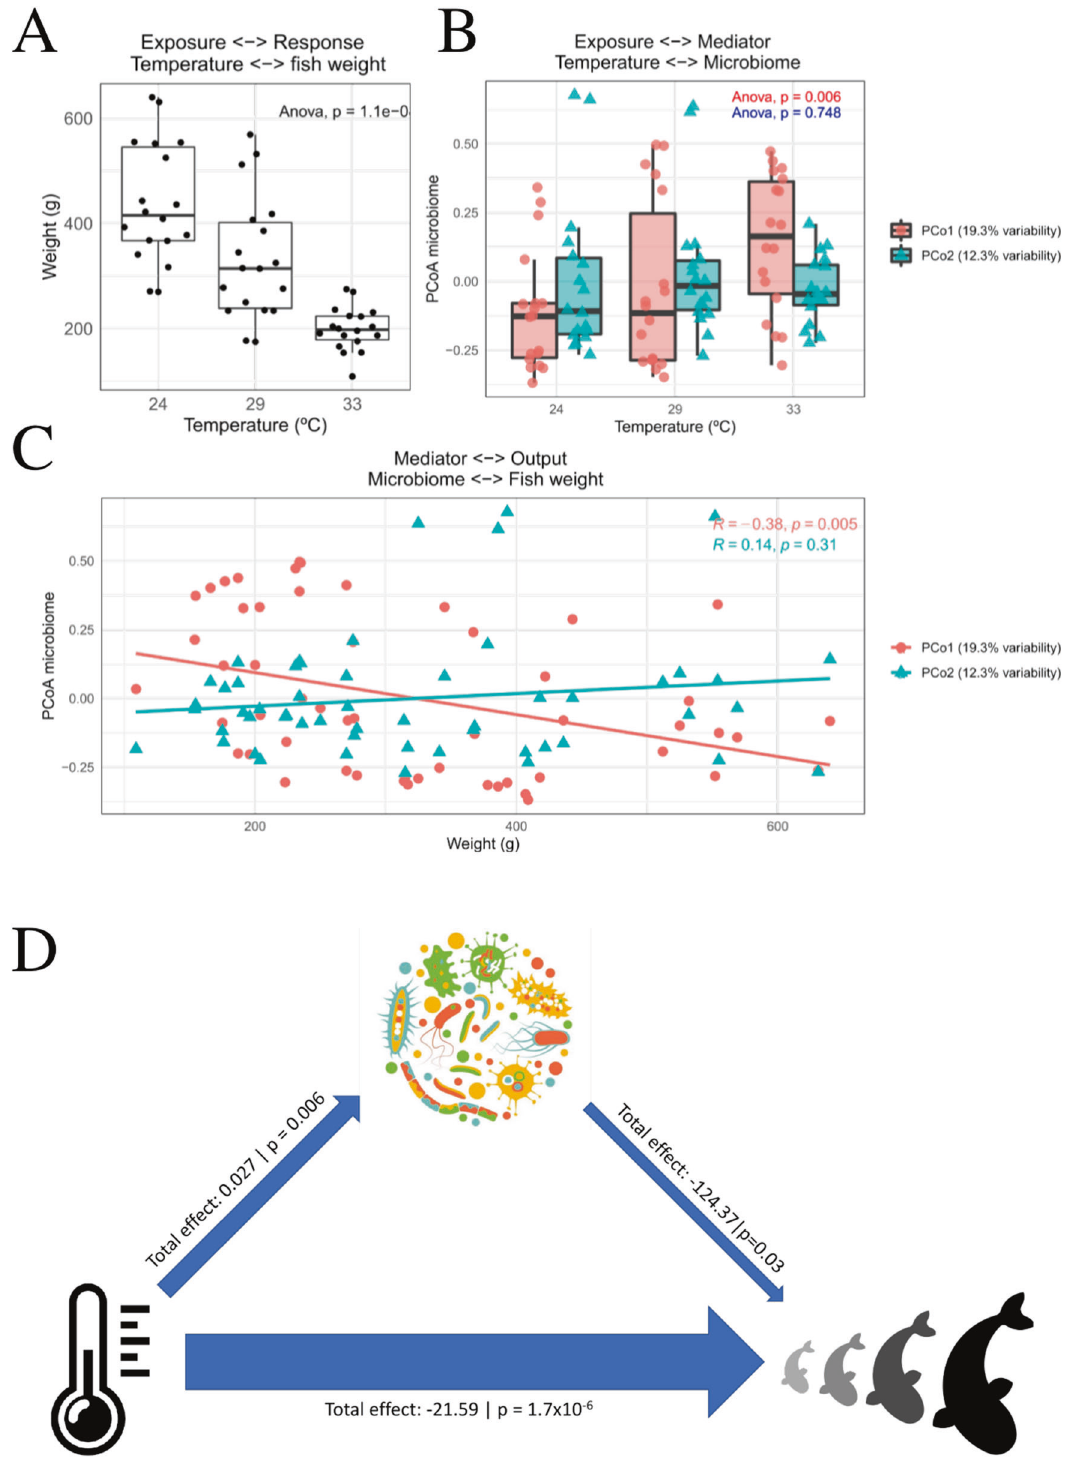
Fig. 4 Causal mediation analysis (CMA) dissecting the total direct effect of temperature on greater amberjack ’ s growth, and the indirect effect mediated through the greater amberjack ’ s gut microbiota composition. A Association between the water temperature and the fi sh weight. B Associations between the scores values of the two fi rst coordinates derived from the PCoA transformation of the Bray – Curtis distance matrix and the water temperature. C Correlations between the microbiota, summarized as the scores values of the fi rst two beta diversity coordinates, and the fi sh weight. D Summary of the mediation analysis. The design of the analysis was to consider temperature as the exposure, fi sh weight as the response and the gut microbiota, summarized as the fi rst beta diversity coordinate, as the mediator. Each arrow indicates the total effect between each pair of variables, including its p -value. Arrows width indicates the effect size of each